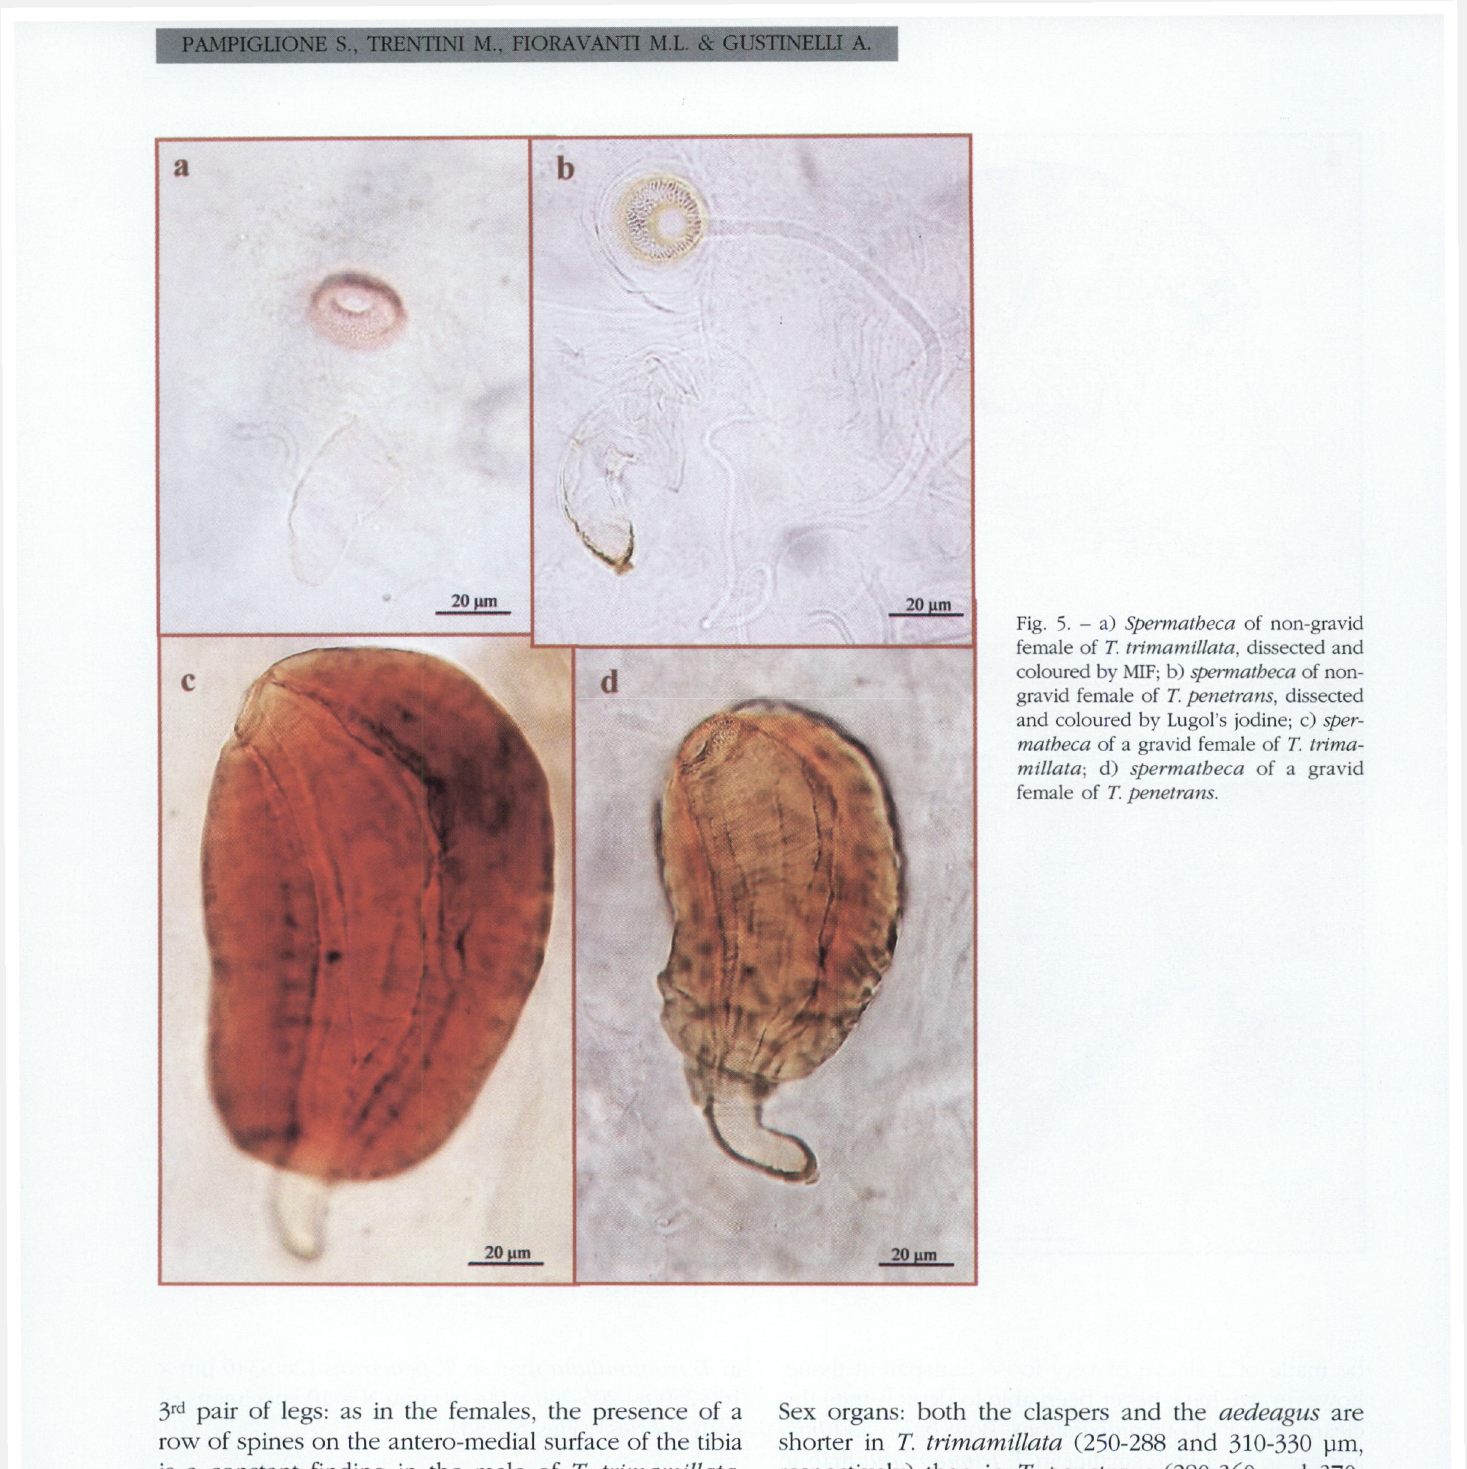
Fig. 5. - a) Spermatheca of non-gravid female of T. trimamillata, dissected and coloured by MIF; b) spermatheca of non- gravid female of T. penetrans, dissected and coloured by Lugol’s jodine; c) sper­ matheca of a gravid female of T. trima­ millata ; d) spermatheca of a gravid female of T. penetrans.